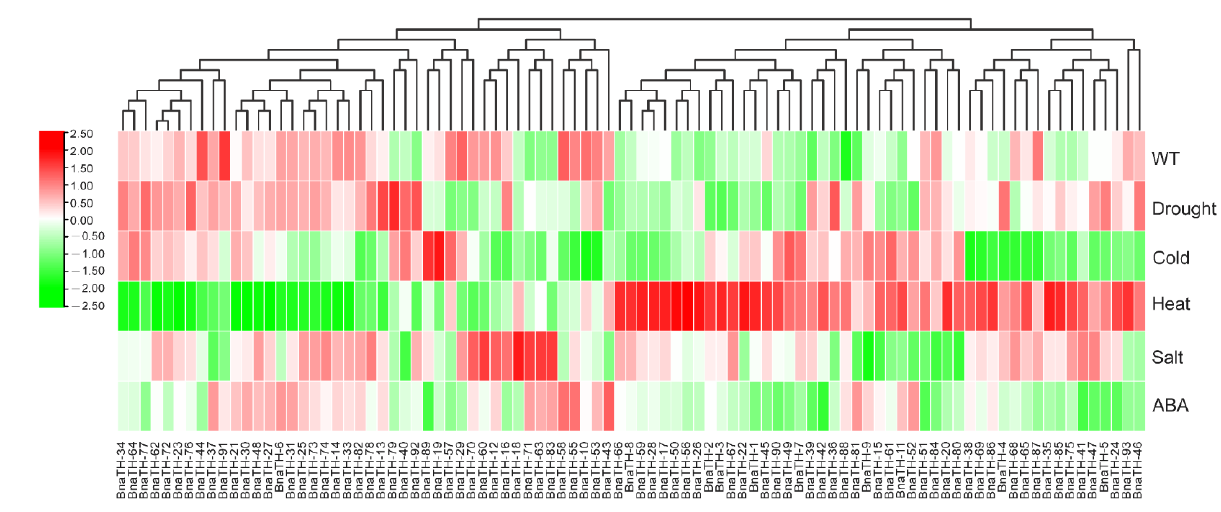
Figure 9. Expression patterns of BnaTH under different stresses. FPKM values of BnaTH genes transformed by log2 were used in TBtools to construct heat maps. Expression levels are depicted by the different colors on the scale. Red and green represent high and low expression levels respectively.